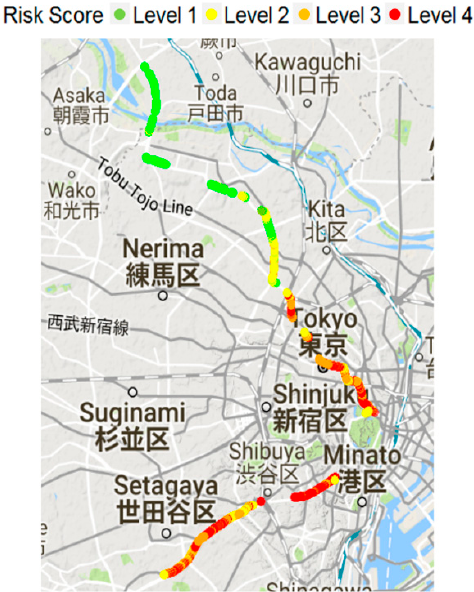
Figure 17. Risk score map of the Tokyo region.